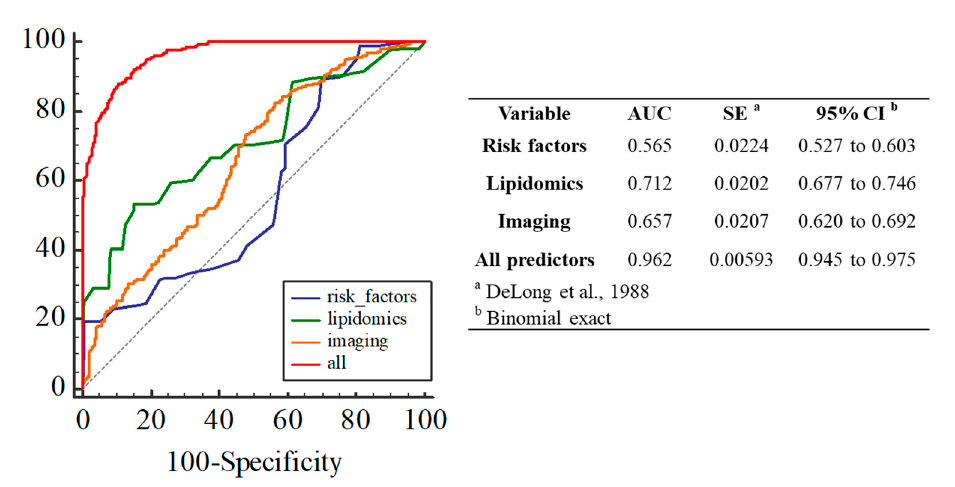
Figure 3. ROC curves of the risk score models comparing the predictive effect of each different feature sets.